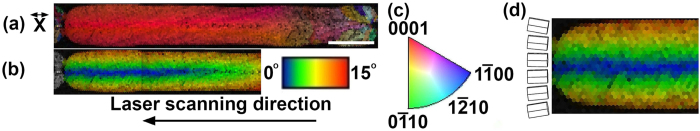
Lattice misorientation in laser induced crystal in glass.(a) X-axis IPF map of a crystal line grown at 209 GW/m2 and 15 μm/s showing highly oriented growth over a 100 μm length. Scale bar corresponds to 25 μm. (b) Map of angular misorientation with respect to the c-axis oriented along the laser scanning direction. (c) Inverse pole figure. (d) Close-up view of the misorientation map at the left end of the crystal line along with lattices to illustrate the misorientation.